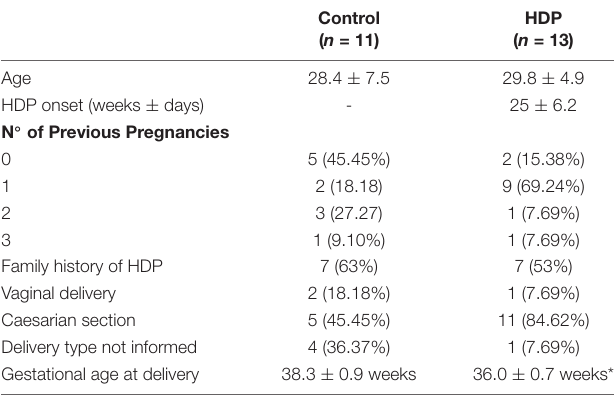
TABLE 2 | General characteristics between normal vs. subjects with Hypertensive Disorders in Pregnancy (HDP) ( ≥ 140/90 mmHg).